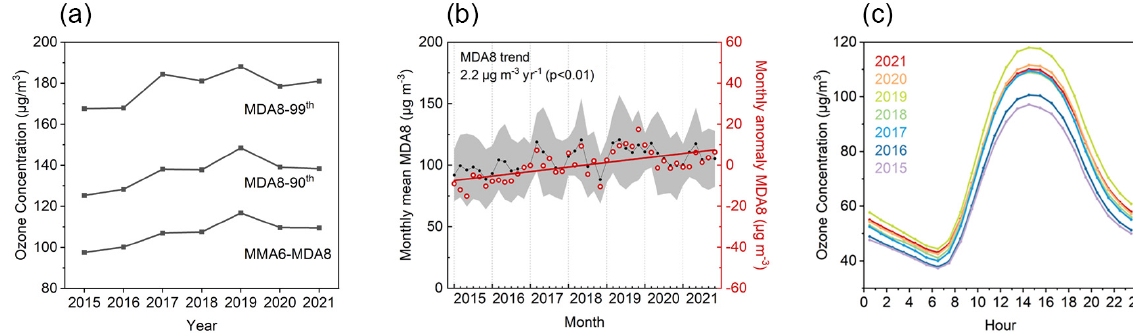
Figure 1. Surface ozone concentrations in China. (a) MDA8-99th, MDA8-90th, MMA6-MDA8 and (b) monthly average (black dots, left axis) and anomaly (circle, right axis) of MDA8 ozone concentrations averaged for all 367 cities with monitoring sites in 2015–2021. Gray shading: mean value ± standard deviation across all cities for each month. Solid line: linear fitted curve. (c) Ozone diurnal cycles from April to September.